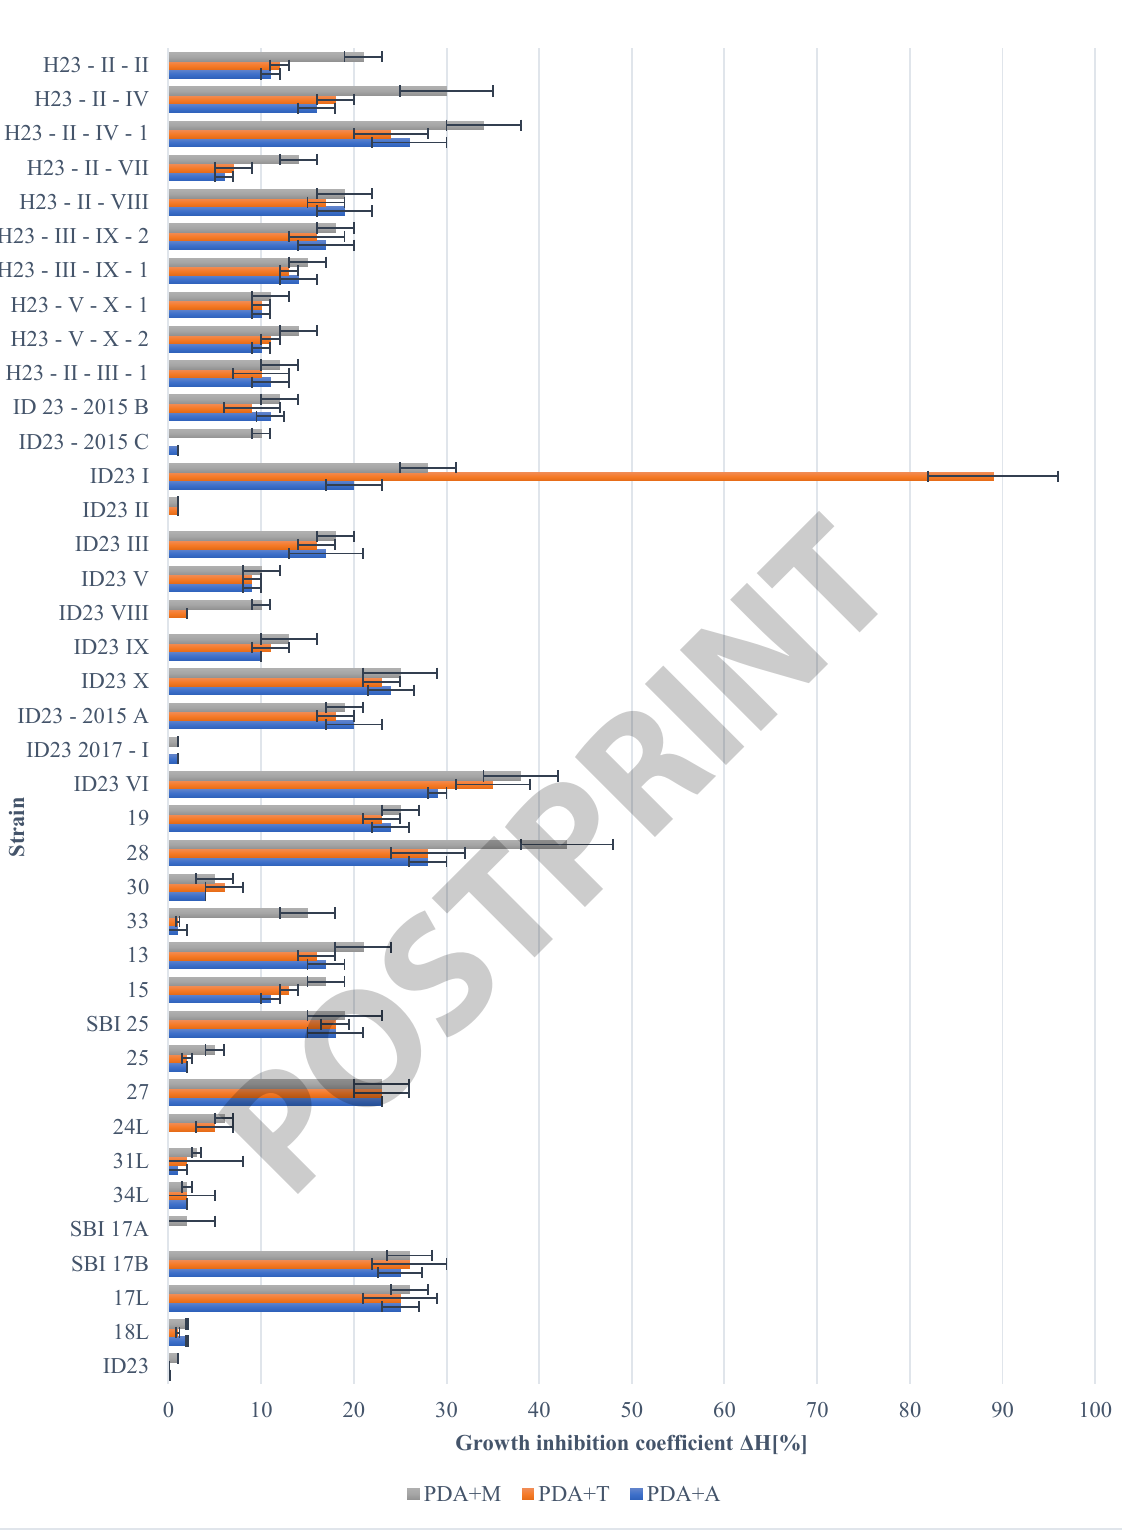
Figure 4. I nfluence of selected fungicides (10 ppm) on the growth of individual isolates of R. solani AG5 showed as an inhibition coefficient (ΔH%) ( PDA+A - azoxystrobin, PDA+M - thiophanate - methyl , and PDA+T -